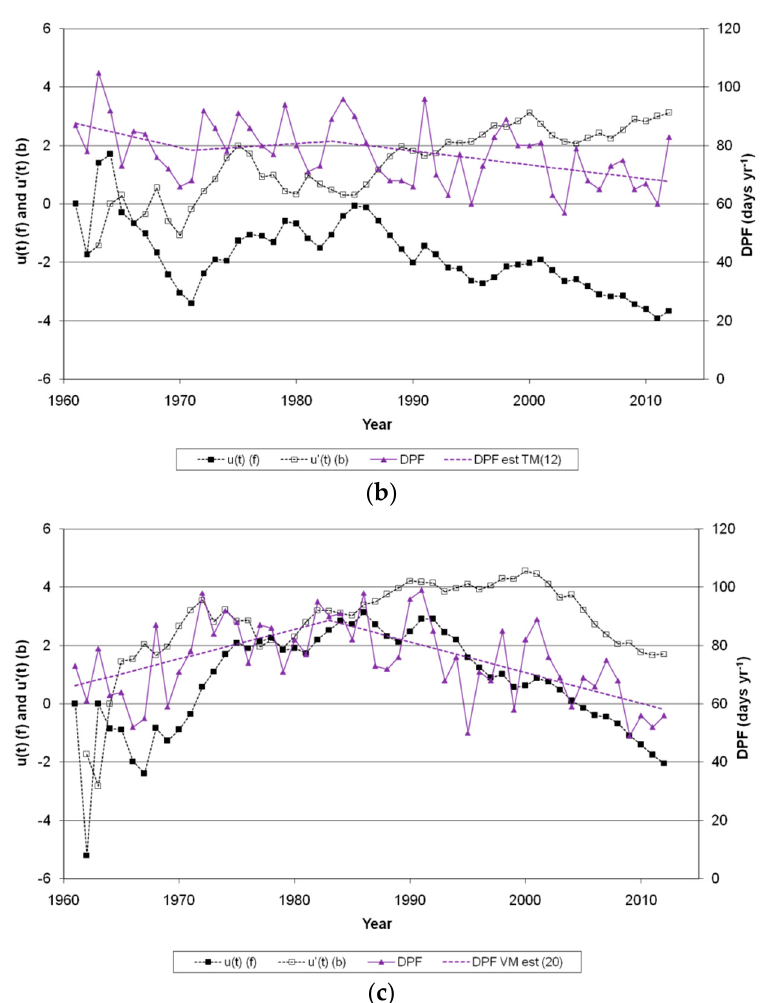
Figure 5. Annual variation of rainy days per year (DPF) at BO ( a ), RC ( b ), and VM ( c ) between 1960 and 2012, and determination of the breakpoint from Mann–Kendall–Sneyers, where u(t) and u’(t) are the test values forward (f) and backward (b), respectively, and from Tomé–Miranda (TM), where MINIX = 20 for ( a ) and ( c ) and 12 for ( b ).